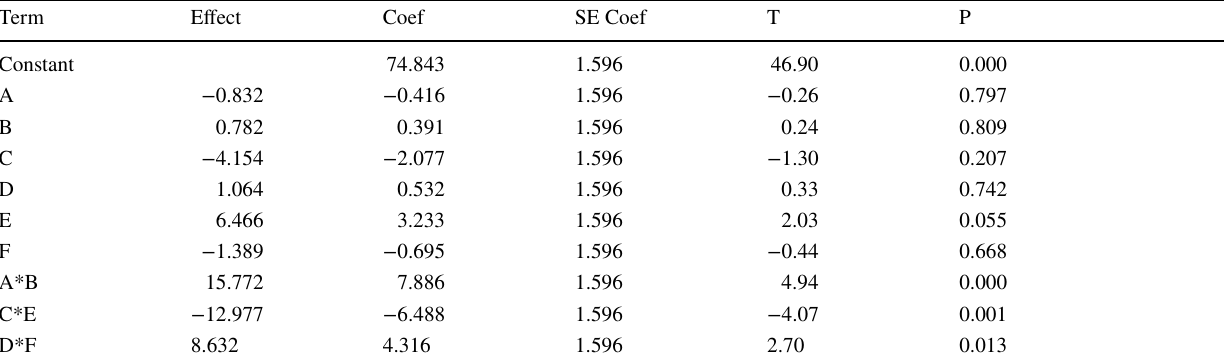
Fig. 8 Correlation between theoretical and experimental % E of